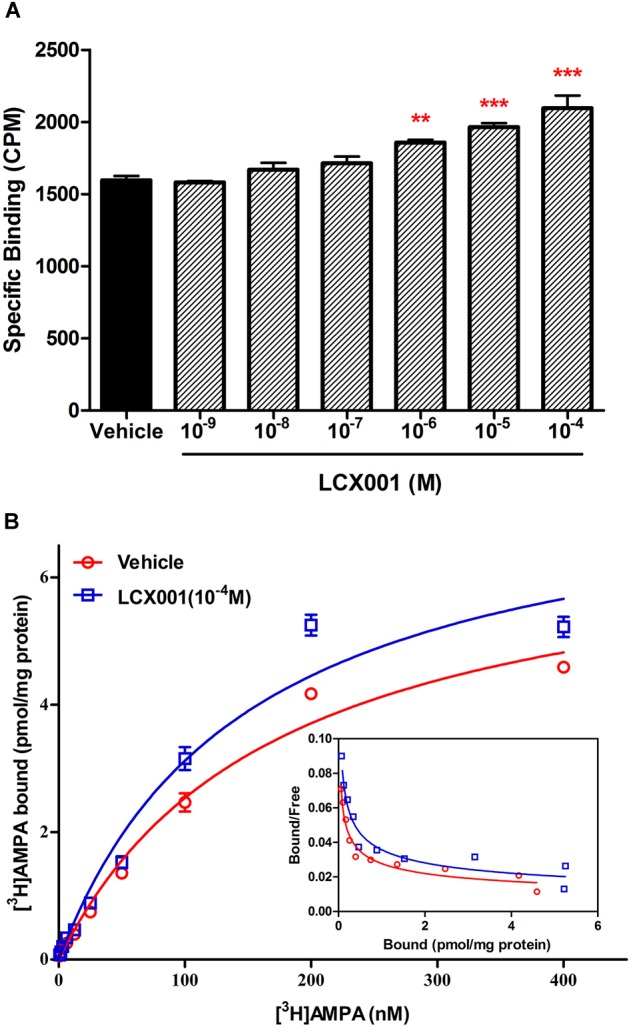
LCX001 facilitated [3H]AMPA binding. (A) Effects of preincubation of LCX001 at increasing doses (10-9–10-4 M) on [3H]AMPA binding. The specific binding of [3H]AMPA to AMPA receptors in tissues was significantly improved in the presence of LCX001 at 10-6, 10-5, and 10-4 M. ∗Significant difference by one-way ANOVA, Dunnett’s test (LCX001 treatment groups vs. vehicle group;∗∗P < 0.01, ∗∗∗P < 0.001); mean ± SEM, three separate experiments were performed in triplicate. (B) Saturation binding curves and Scatchard plots (inset) of [3H]AMPA binding in the preincubation and absence from LCX001 (10-4 M). The concentrations of [3H]AMPA were set to 400 nM. The results were analyzed by one-site logistic curve-fitting equation, and the Kd and Bmax values given in the text indicated that binding affinity and the number of binding sites were increased after treatment of LCX001. The Kd and Bmax values were individually mentioned in the text. Values are the mean ± SEM of results from six separate experiments.